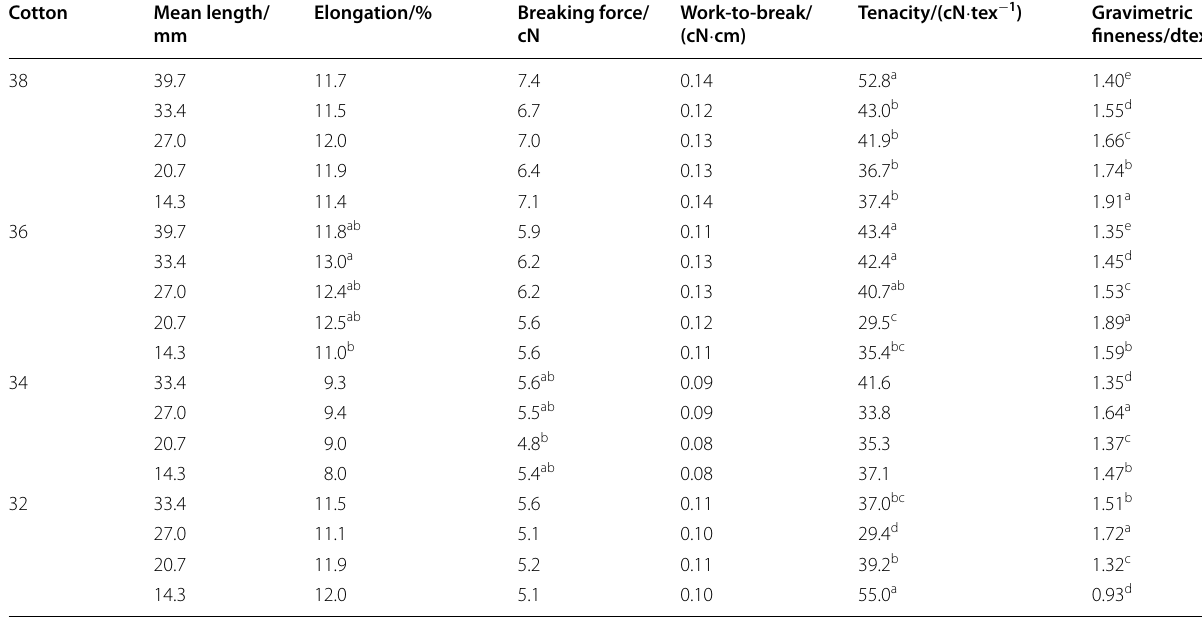
Means that do not share a letter are significantly different, where no letter is present there are no differences